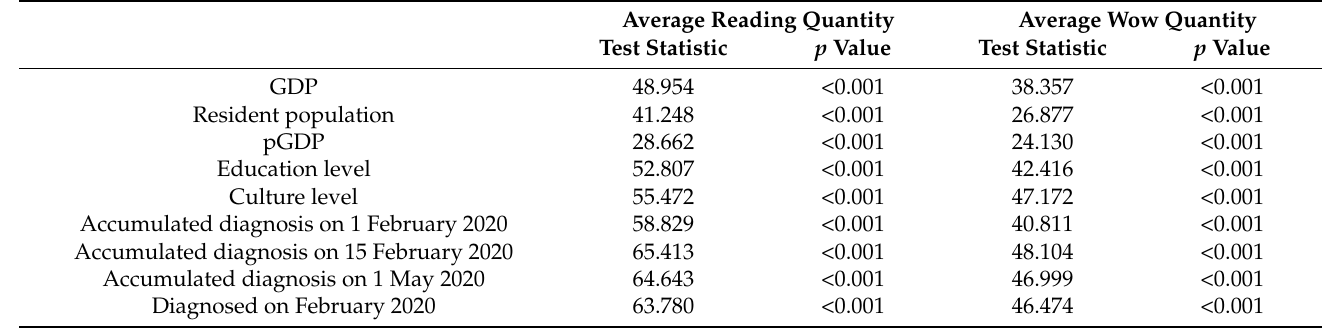
Table 4. Statistical analysis of the influencing factors of risk communication